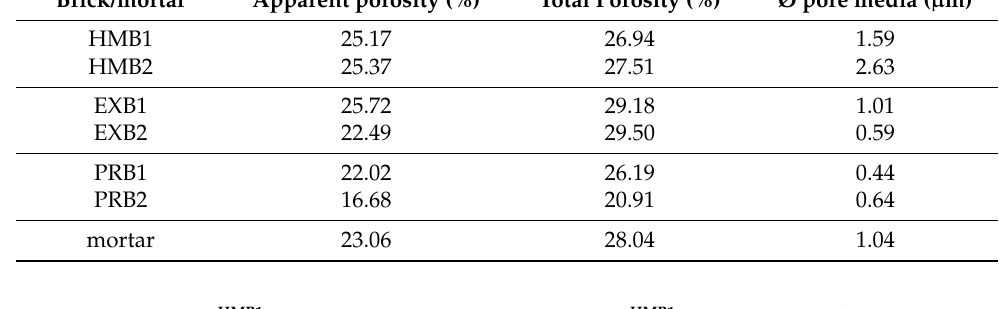
Table 3. Material properties: apparent porosity, brick porosity and average pore size.